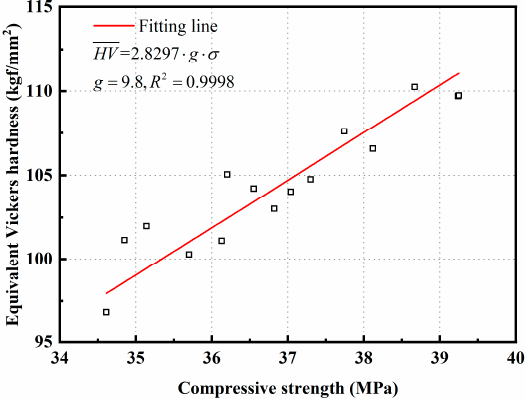
Figure 10. Relationship between HV and compressive strength. Figure 10 indicates that HV and compressive strength are excellently correlated,